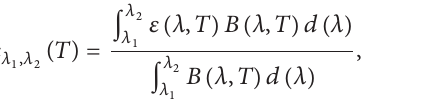
Figure 4: Sectional image of sample 30 b observed with SEM 6000x. From top to bottom, it is possible to distinguish the stainless steel in grey and the Ni layer in light grey. The black line is empty space due to the partial detaching of the holder resin (the dark grey layer at the bottom of picture).